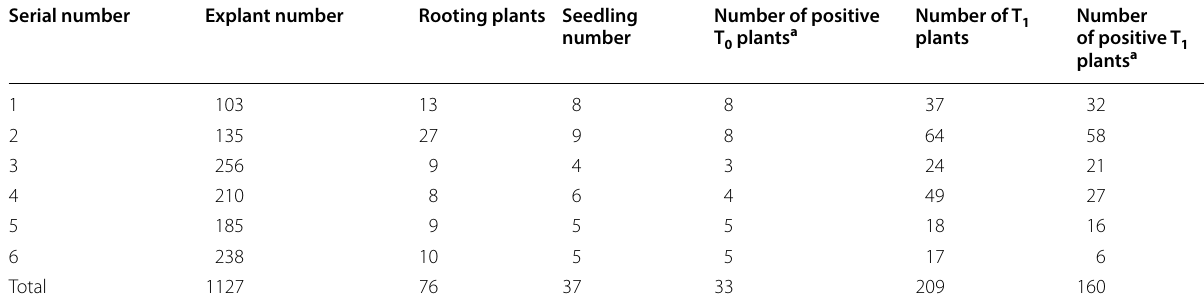
and T GmVma12 transgenic generations 0 1